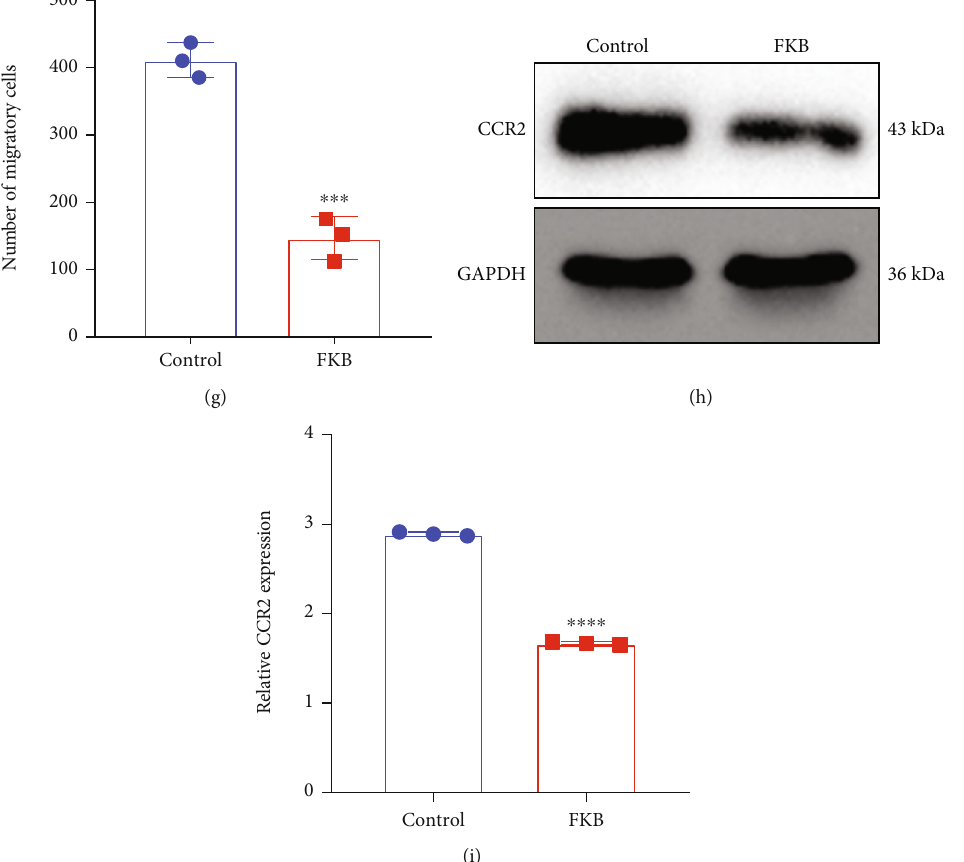
Figure 8: FKB-treated gastric cancer cells polarize macrophages toward M1 phenotype and weaken macrophage migration. (a – e) Western blot of the expression of iNOS and CD86 (M1) as well as Arg-1 and CD206 (M2) in THP-1 cells treated with conditioned media from normal or FKB-treated SGC-7901 cells. (f, g) Transwell of THP-1 cells treated with conditioned media from normal or FKB-treated SGC-7901 cells. Bar, 100 μ m. (h, i) Western blot of the expression of CCR2 in THP-1 cells treated with conditioned media from normal or FKB-treated SGC-7901 cells. ∗∗∗ p < 0 : 001 ; ∗∗∗∗ p < 0 : 0001 .